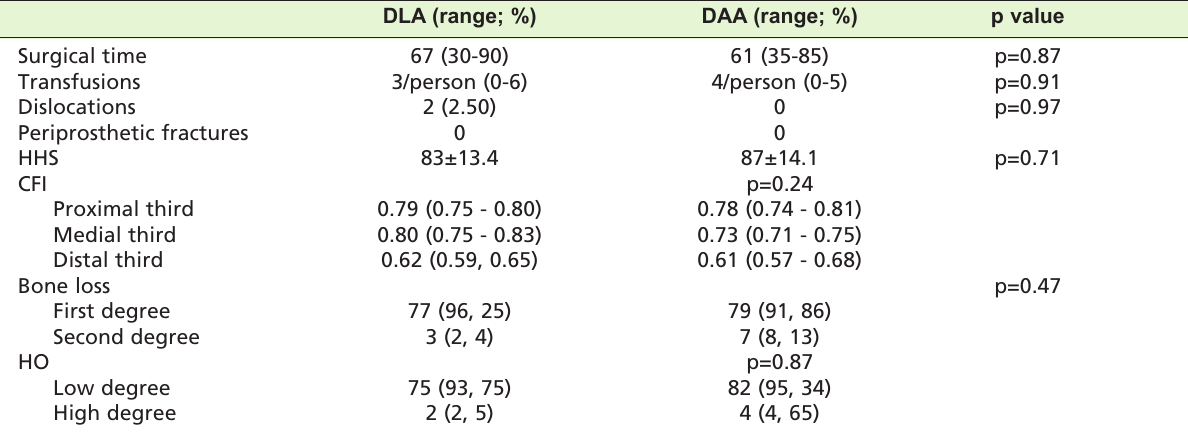
Table II: Results. (HHS: Harris Hip Score, CFI: Canal Fill Index, HO: Heterotopic Ossification) DLA (range;